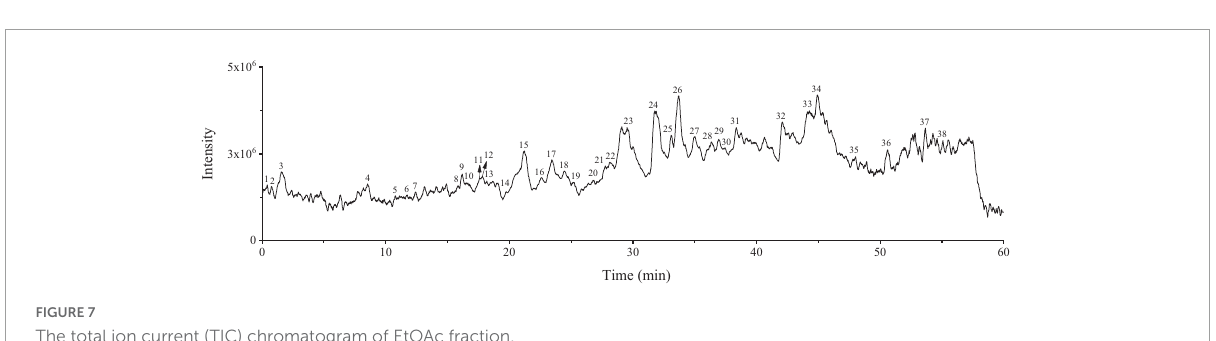
FIGURE7 The total ion current (TIC) chromatogram of EtOAc